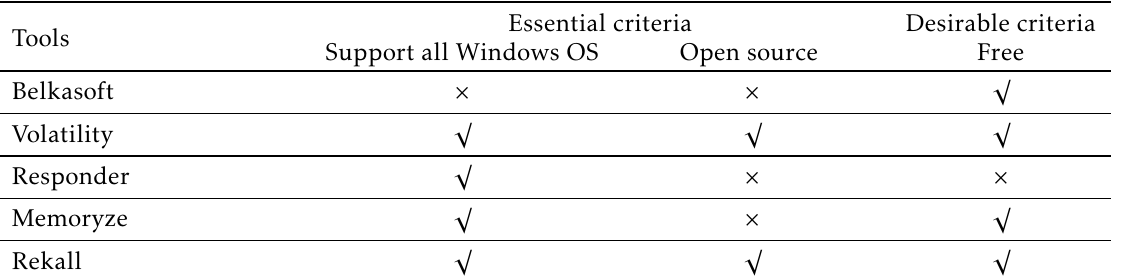
Table 2. Essential and the desirable criteria of memory images analysis tools